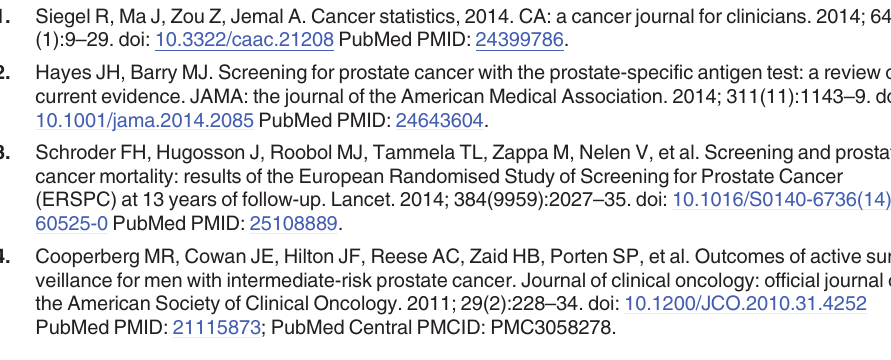
S1 Fig. Normalization of serum miRNA levels. RT-qPCR for serum miRNAs. Relative Quan- tification (RQ) value determined by ddCt. A, RQ values that were used to normalize miRNA levels; total RNA input and the spike-in controls Sp3 (PCR inter-plate calibration), Sp6 (cDNA synthesis efficiency) and cel-miR-39 (RNA extraction). B, RQ values for normalizers that were not suitable for the study; let-7a, miR-103 and mean miR Ct of each sample. (TIF) S2 Fig. Serum miRNAs and gross hemolysis of the sera. A, criteria for hemolysis. B, RT- qPCR RQ expression was log2 transformed and the median-/+ inter-quartile range for each miR is shown by hemolysis status of the serum. L = low (N = 125), I = intermediate (N = 21) and H = high (N = 16) gross hemolysis. S3 Fig. Receiver-operator characteristic (ROC) curves for miR Scores. ROC and AUC analy- sis for A, miR Score1 and low — grade PCa, B, miR Score2 and absence of high-grade PCa, C, the miR Risk Score and BCR-free survival. S4 Fig. Removal of older serum sample does not alter results. Analysis by year of serum col- lection between the groups by, A, RNA recovery, and, B, mean miR Ct (log2). C, analysis of miRNAs by group after removal of 14 patients with serum collections (cid:1) 1990; RQ on y-axis. (cid:3) p < 0.05, (cid:3)(cid:3) p < 0.01, (cid:3)(cid:3)(cid:3) p < 0.0001 by Kruskal – Wallis one-way analysis of variance with Dunn's multiple comparisons